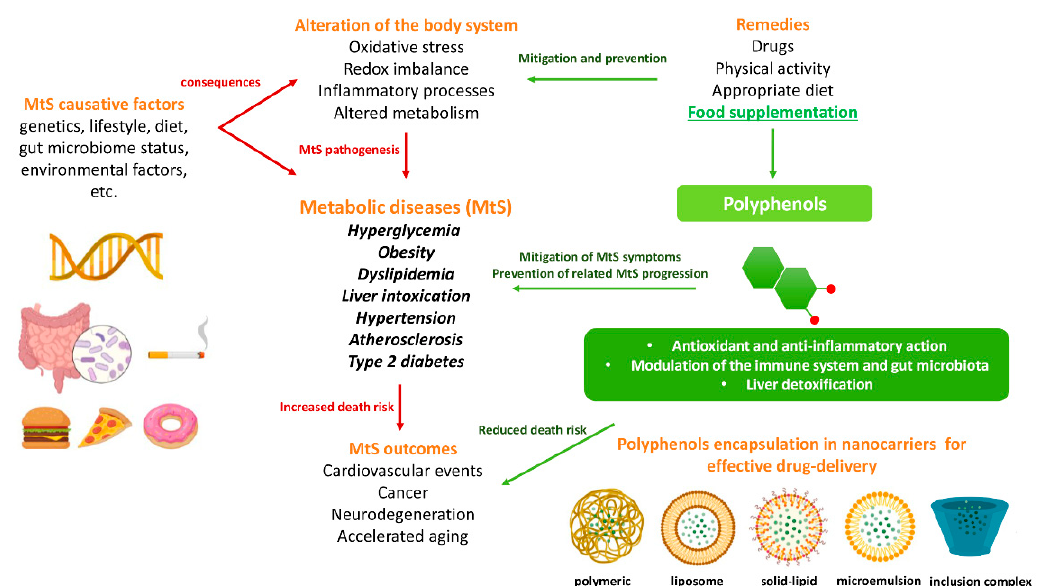
Figure 2. Influences of PPs on different manifestations of MtS.